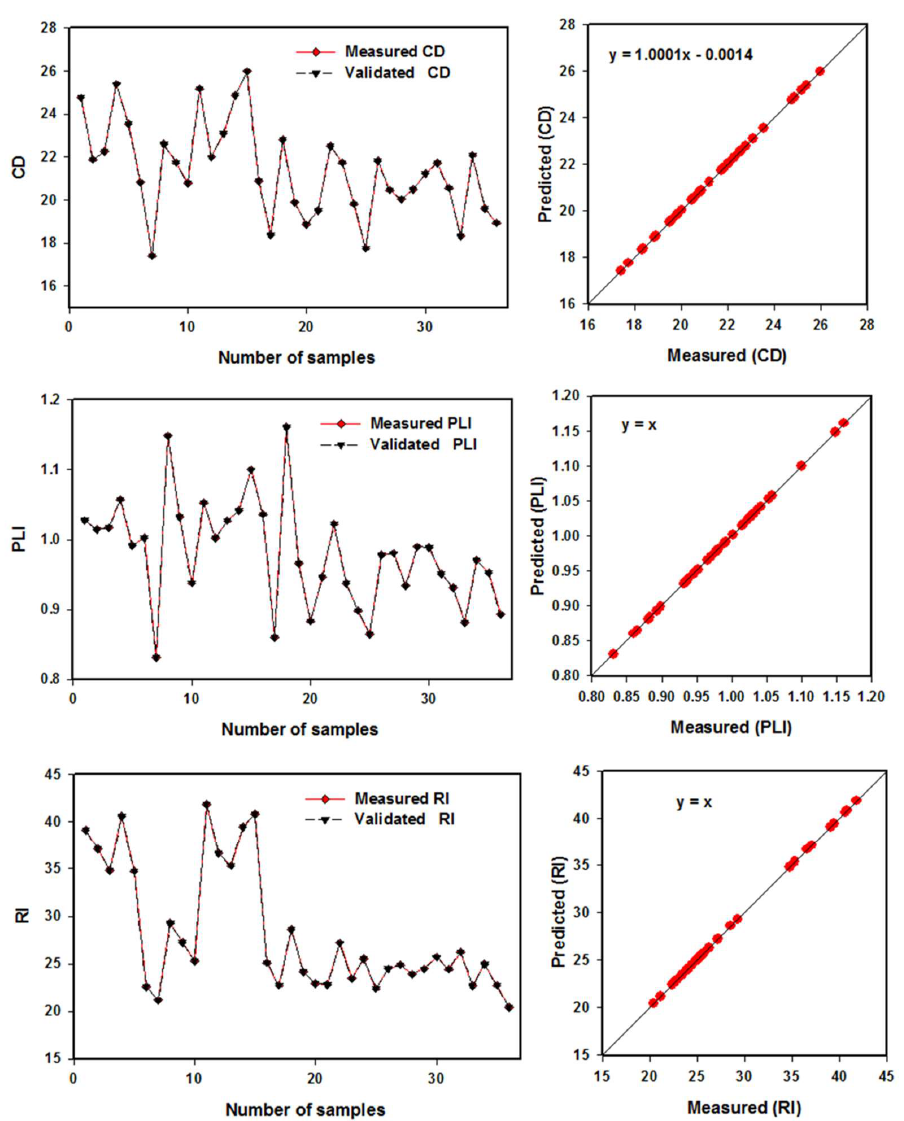
Figure 6. Comparison between measuring datasets, and validating datasets contamination